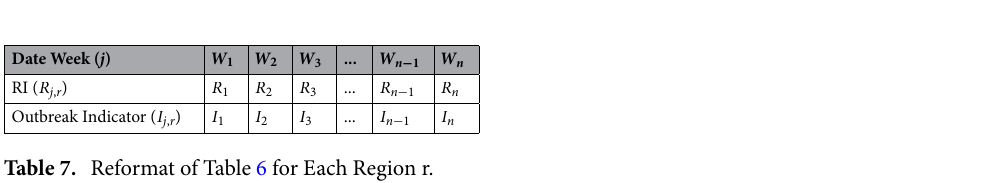
Table 7. Reformat of Table 6 for Each Region